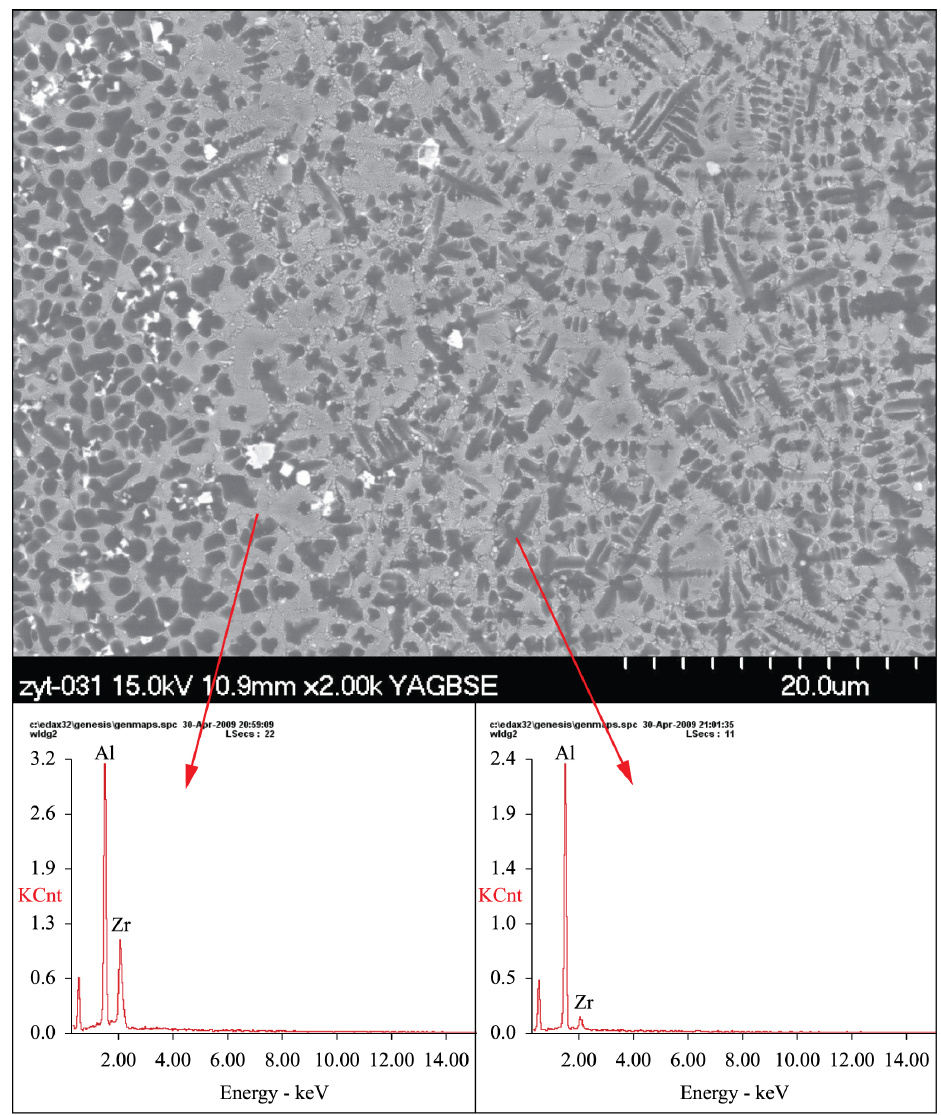
Figure 7. Back scattering electron image and EDS of the dendrite